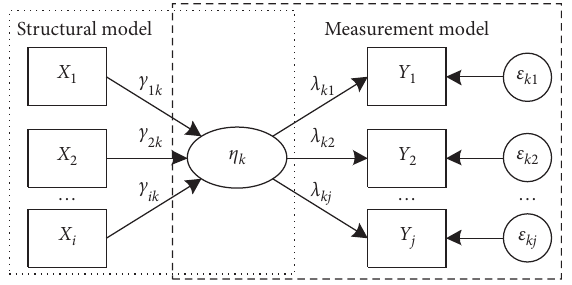
Figure 1: Diagram of the MIMIC model.